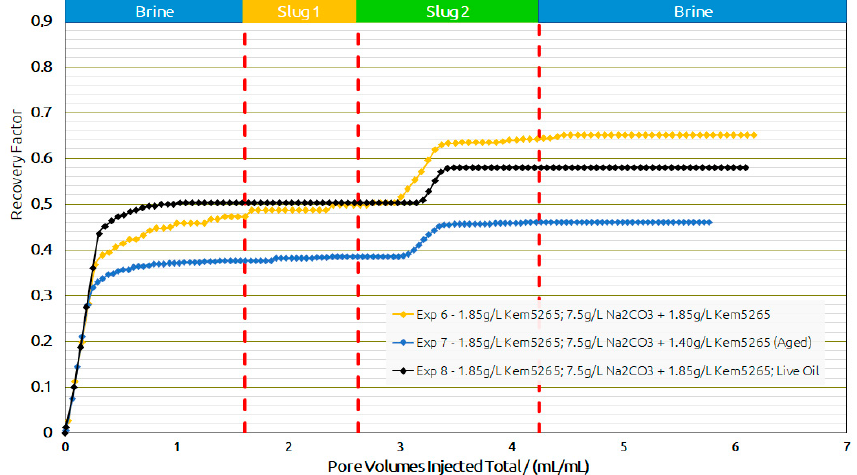
Figure 17. Recovery factor versus pore volumes injected total for the different slugs for core